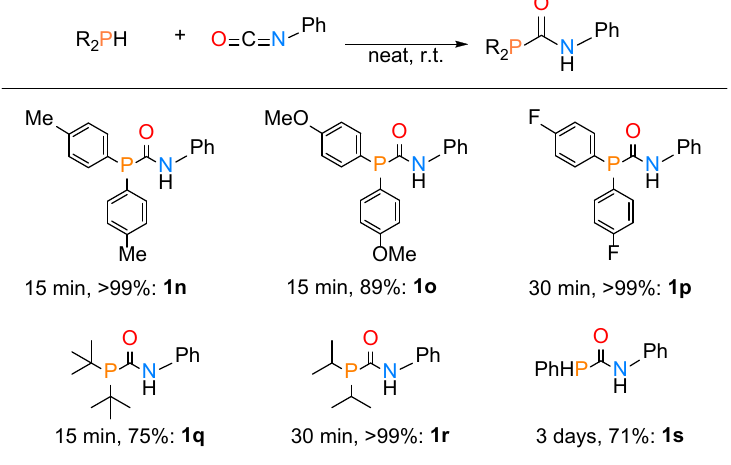
Scheme 3. Hydrophosphination of phenylisocyanate with secondary phosphines R 2 PH and